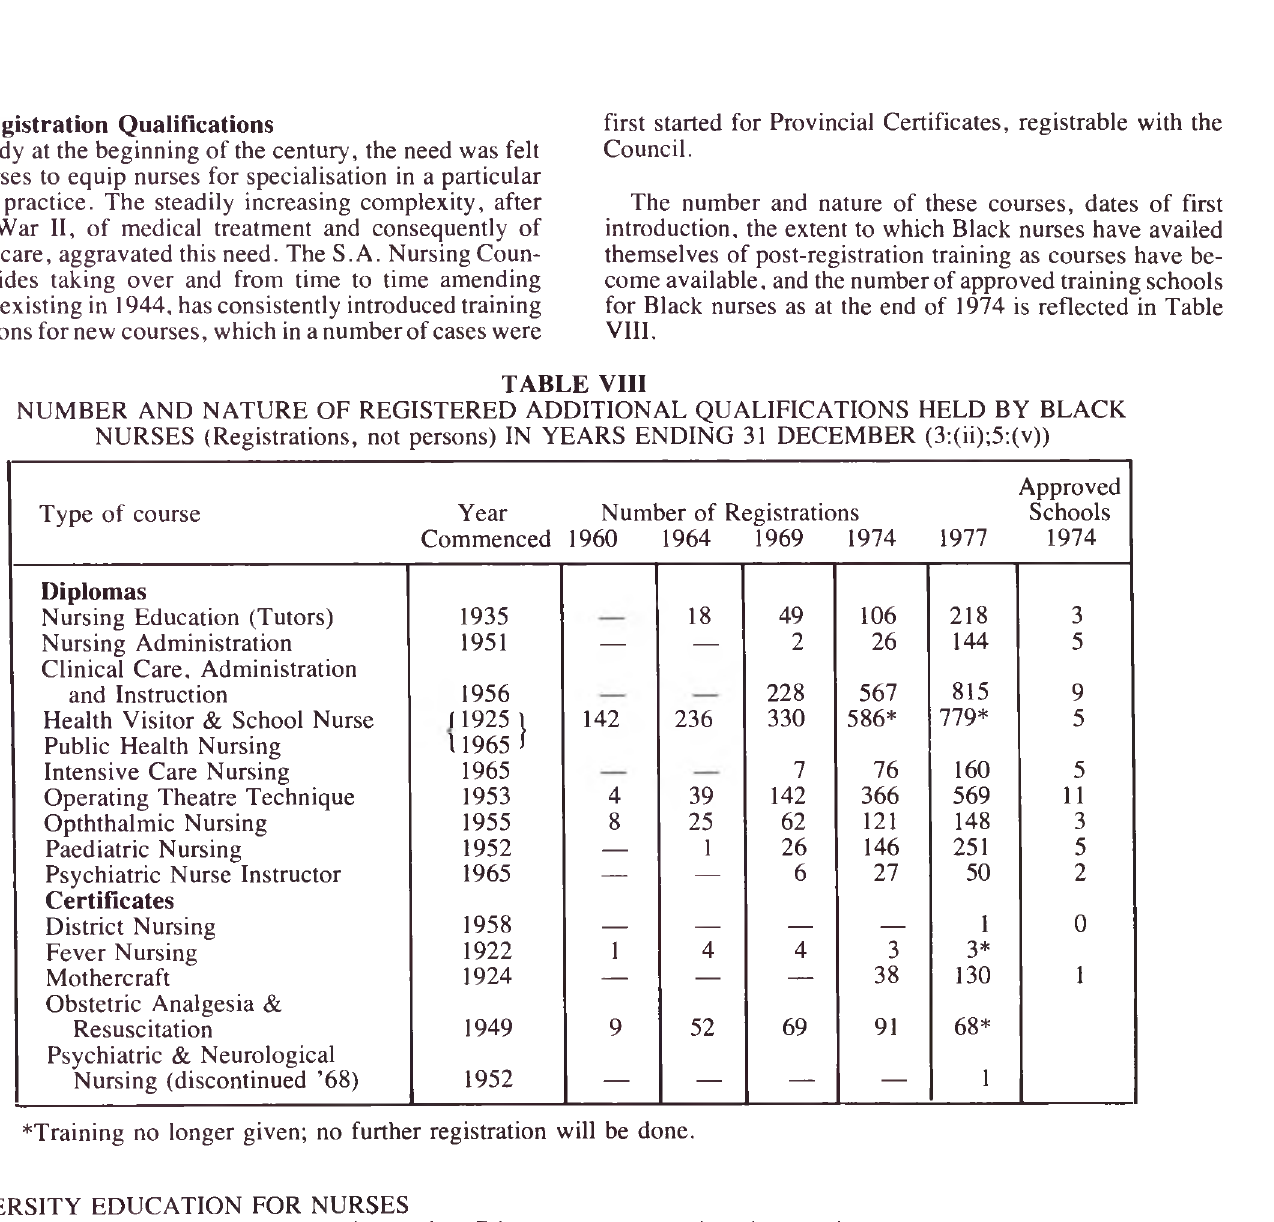
TABLE VIII NUMBER AND NATURE OF REGISTERED ADDITIONAL QUALIFICATIONS HELD BY